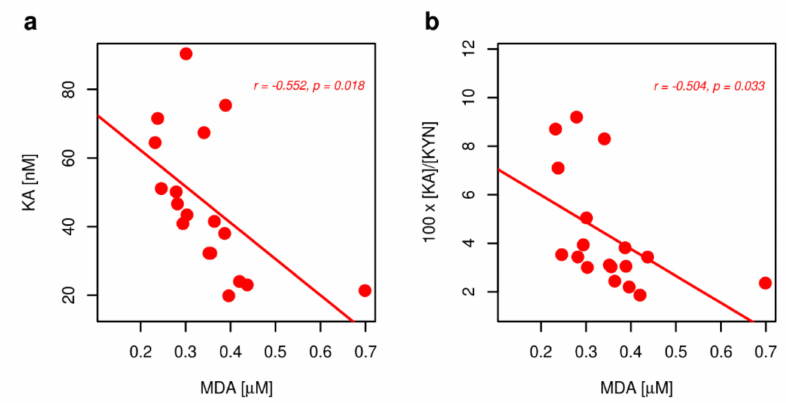
Figure A1. Correlation graphs of OS marker MDA with KA ( a ) and with 100 × [KA] / [KYN] (activity of KMO) ( b ) in plasma of AIS patients. Abbreviations: MDA: malondialdehyde; KA: kynurenic acid; KMO: kynurenine 3-monooxygenase.